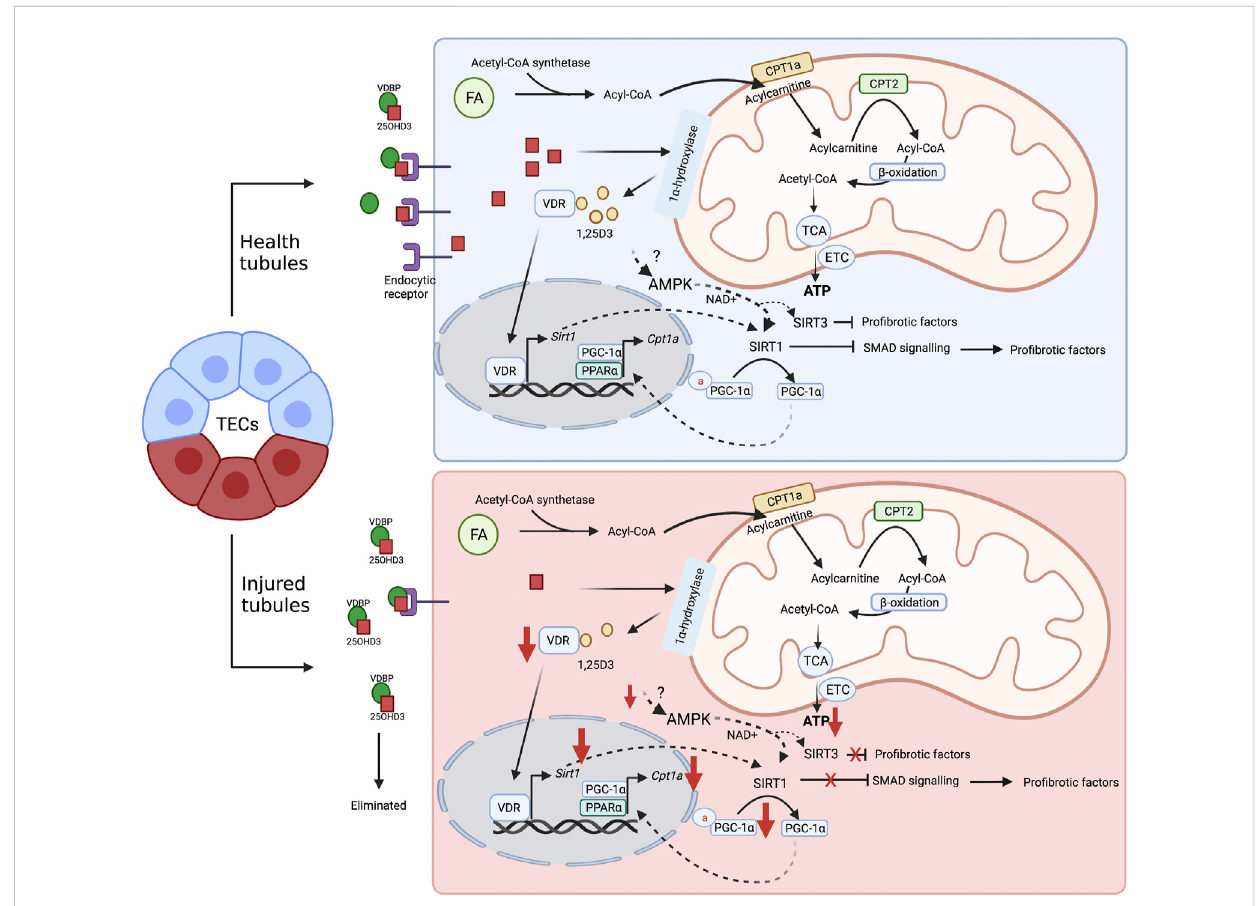
Proposal mechanism of VitD on healthy and injured tubular cell metabolism. FAO (or β -oxidation) is the main energy source of TECs. In the cytoplasm, FAs are transformed into Acyl-CoA by the enzyme Acyl-CoA synthetase. Then, the mitochondrial enzyme CPT1a converts acyl-CoA in acylcarnitine, which can be transported into mitochondrial matrix via carnitine/acylcarnitine translocase. Subsequently, acylcarnitine is subjected to the CPT2activitytobereconvertedintoacyl-CoAandtheFAOisinitiated:acyl-CoAisconvertedintoacetyl-CoA,whichinturn,fuelstheTCAcyclethat providesreducingequivalentstoETCtoproduceATP.VitDmaybeanimportantregulatoroftheFAOinTECs.Afterinternalization via passivediffusionor receptor-mediated endocytosis, 25-hydroxyvitamin D3 is converted into its bioactive form, 1,25D3. The recognition of the active form by VDR causes transcriptional changes and leads to SIRT1 expression, which in turn, promotes the inhibition of pro fi brotic pathways, such as SMAD, and contributes to thedeacetylationofPGC1 α and,thus,sustainingtheFAO.Inaddition,VitDcanalsoactivateSIRT1 via AMPKactivation,whichincreasesNAD + production. In the injured tubules the levels of endocytic receptors are reduced, impairing the optimal internalization of 25-OHD3 (calcitriol), and compromising the VitD activity. The reduced levels of VitD decrease the SIRT1 and SIRT3 expression as well as diminish the function of both PCG1 α and CPT1a. These alterations disrupt the FAO and contribute to pro fi brotic responses. 1,25D3, 1,25 dihydroxyvitamin D3; 25-OHD3, 25-hydroxyvitamin D3; AMPK, adenosine monophosphate-activated protein kinase; CPT, carnitine palmitoyltransferase; FA, fatty acids; FAO, fatty acid oxidation; PGC-1 α ,